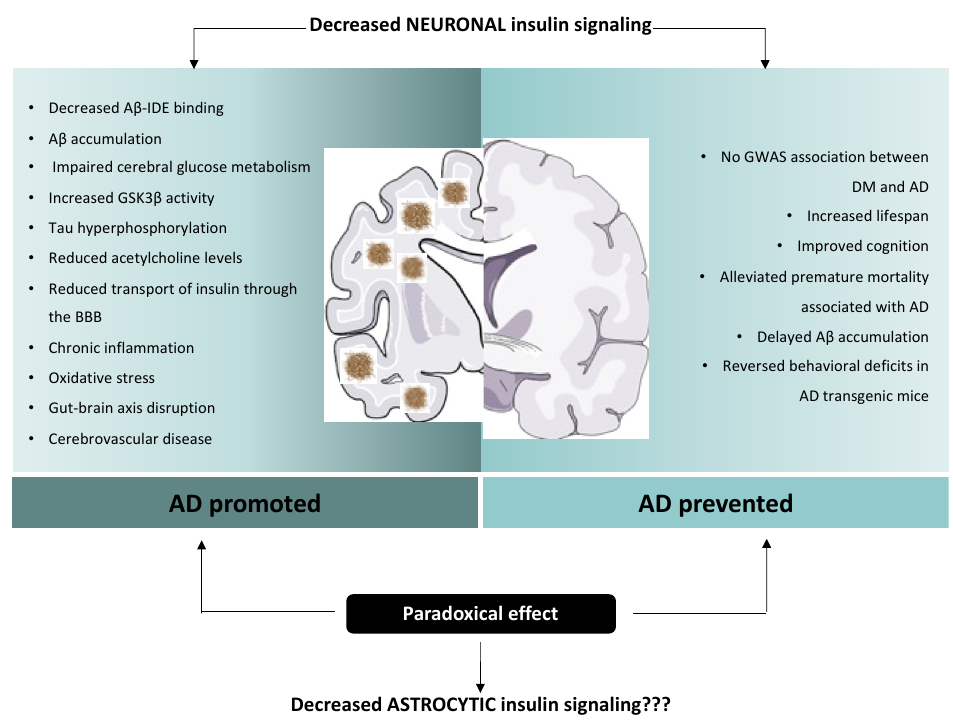
Figure 2. Paradoxical effect of insulin on Alzheimer’s disease etiopathology. Multiple plausible mechanisms have been proposed to explain the connection between insulin resistance and AD. Insulin and A β compete for the binding to IDE, leading to A β protein accumulation. Moreover, cerebral glucose metabolism usually precedes AD signs. In situations of insulin resistance, the activity of GSK3 β is increased and leads to the hyperphosphorylation of Tau. Furthermore, insulin resistance reduces acetylcholine levels in the brain. Chronic state of hyperinsulinemia interferes with the saturable transport of insulin through the BBB. Other possible mechanisms linking DM and AD have also been described, such as chronic inflammation, oxidative stress, disruption of the gut–brain axis and cerebrovascular diseases. Strikingly, a plausible protective role of diminished neuronal insulin signalling has also been proposed. It has been seen that decreased neuronal insulin signalling has a beneficial effect on lifespan regulation, and can even delay age-related processes. Decreased insulin signalling has also been associated with reduced premature mortality associated with AD and delayed A β accumulation. Due to the paradoxical effects of insulin signalling, the current state of our understanding is insufficient to differentiate clearly between the beneficial vs. negative impact on aging and neurodegenerative diseases of reduced insulin signalling. Notably, this debate is fed by results obtained from studies focused exclusively on neuronal insulin signalling; however, the role of insulin action on other brain cell types, such as astrocytes, is still unexplored.